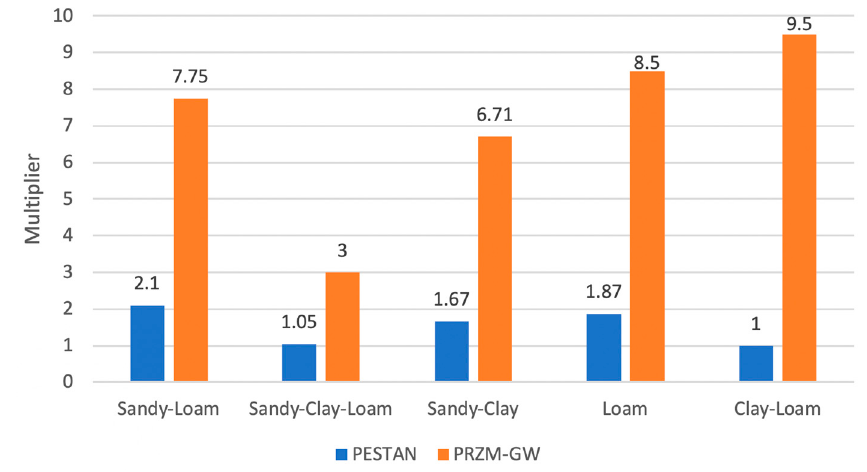
Figure 10. Multiplier values for a 1 kg/ha (annual application vs single dose).